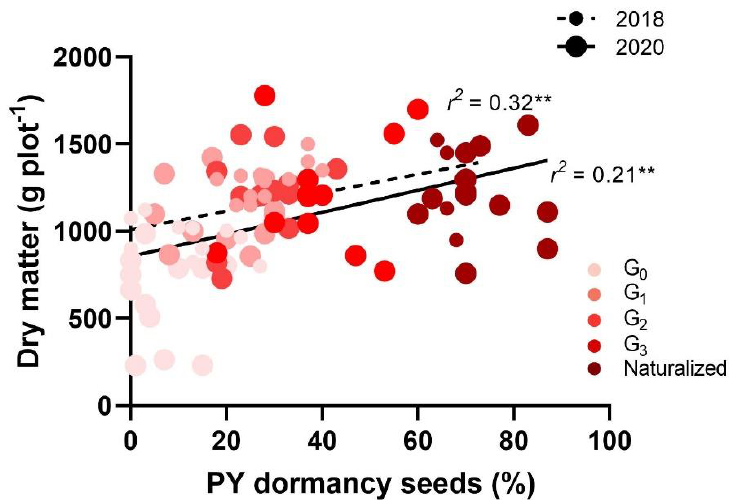
Figure 4. Dry matter per plot (DM) produced by hairy vetch during 2018 and 2020 in relation to the initial PY level of seeds. (** p < 0.01)